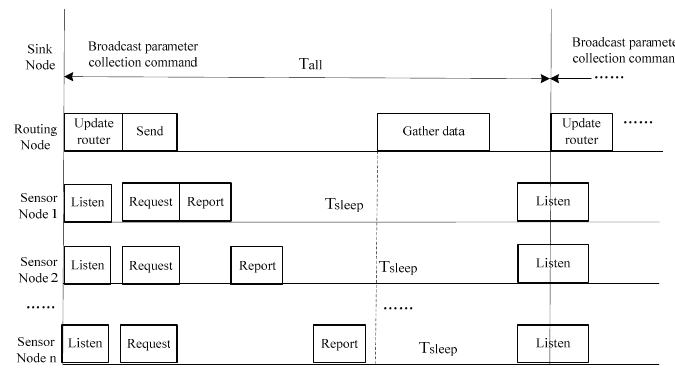
Figure 3. Scheduling of periodic inspection